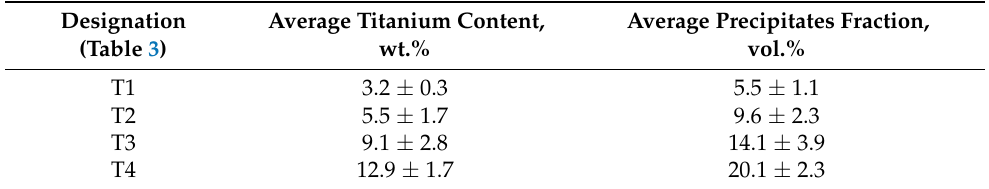
Table 5. The average titanium content and precipitates volume fraction in laser alloyed surface layers.